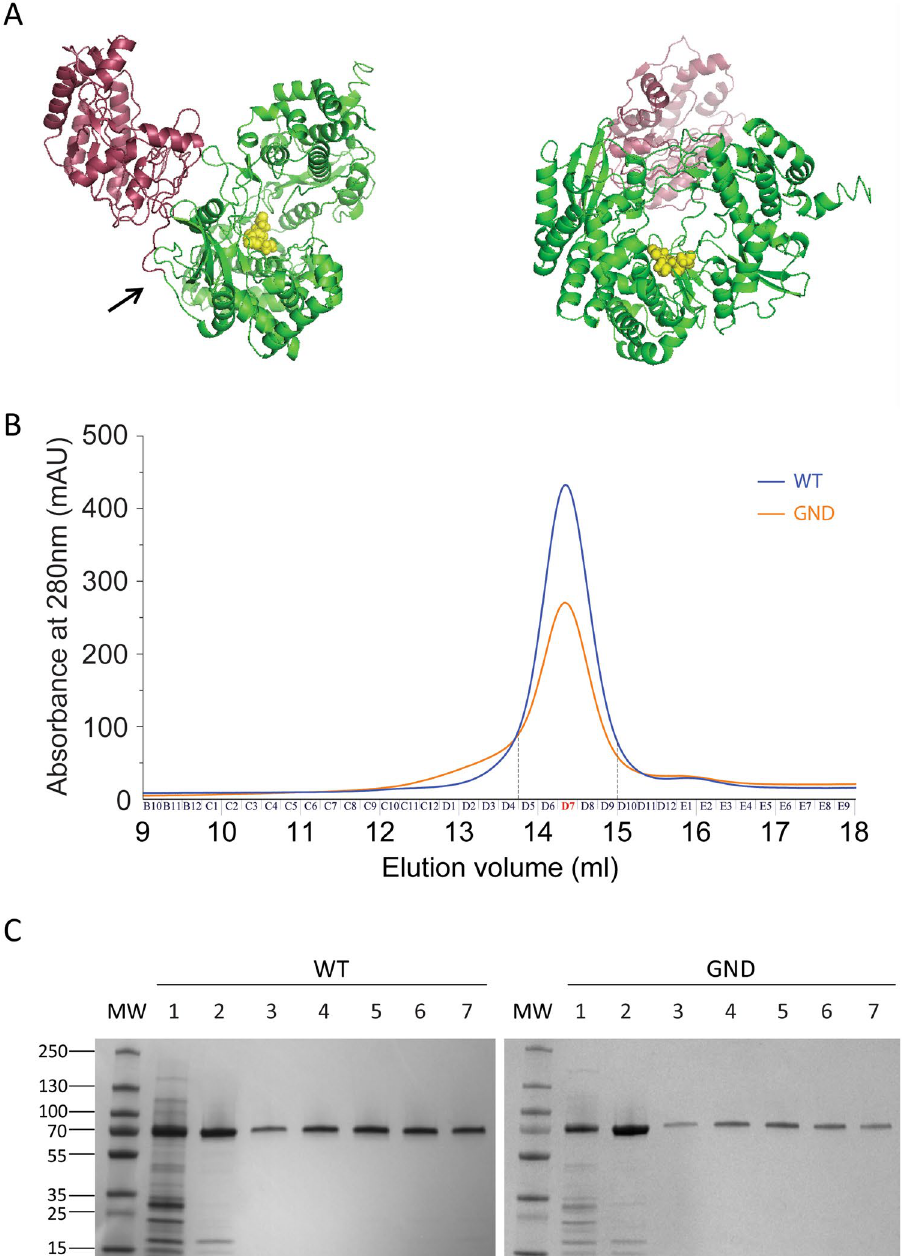
Figure 1. Structure prediction of NS5 and purification of ZIKV polymerase. ( A ) Structure prediction of the NS5 protein of ZIKV. The putative polymerase domain is in green and the MTase domain in purple. The arrow shows the limit between the MTase and the RdRp domain that was cloned. The three amino acids of the potential active site GDD appear as yellow spheres. Images were obtained following a 45° rotation. ( B ) Size exclusion chromatography profiles. Chromatograms correspond to the retention profile of the WT enzyme (blue) and catalytic mutant GND (orange). ( C ) SDS-PAGE analysis of polypeptides throughout the purification of WT (left) and catalytic mutant GND (right) ZIKV RdRp. MW corresponds to the molecular weight. Lane 1 corresponds to 4 µ g of total protein pooled from the nickel column elution. Lane 2 corresponds to 3 µ g of total protein pooled from the heparin column. Lanes 3 to 7 correspond to 0.4 µ g of protein from fractions D5 to D9 obtained during size exclusion Proteins were stained with Coomassie Brillant blue